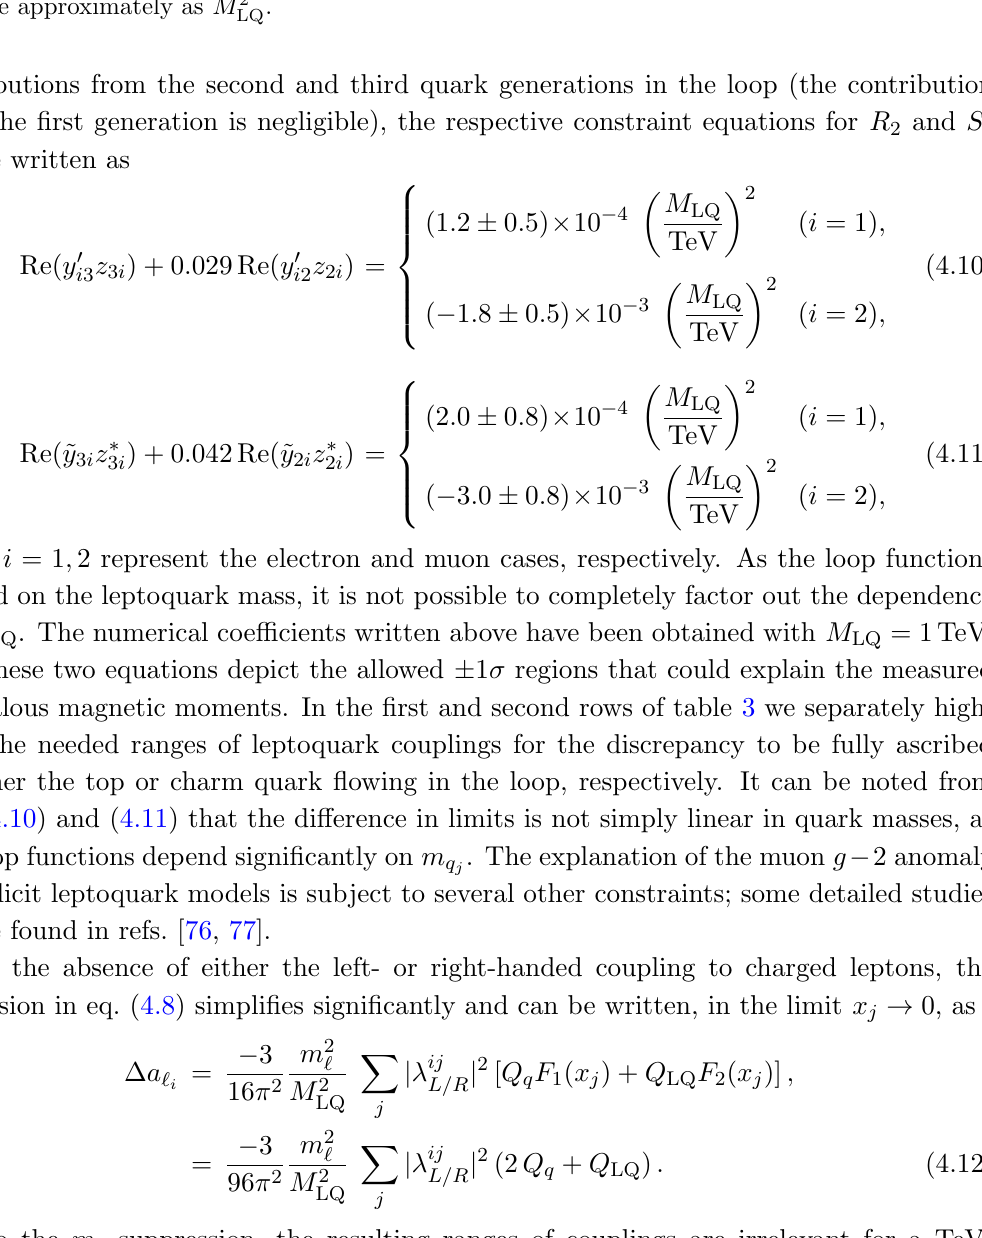
Table 3 . 1 (cid:27) ranges of R 2 and S 1 leptoquark couplings able to explain the electron and muon anomalous magnetic moments, for M LQ = 1 TeV. For larger leptoquark masses, the numbers increase approximately as M 2 LQ